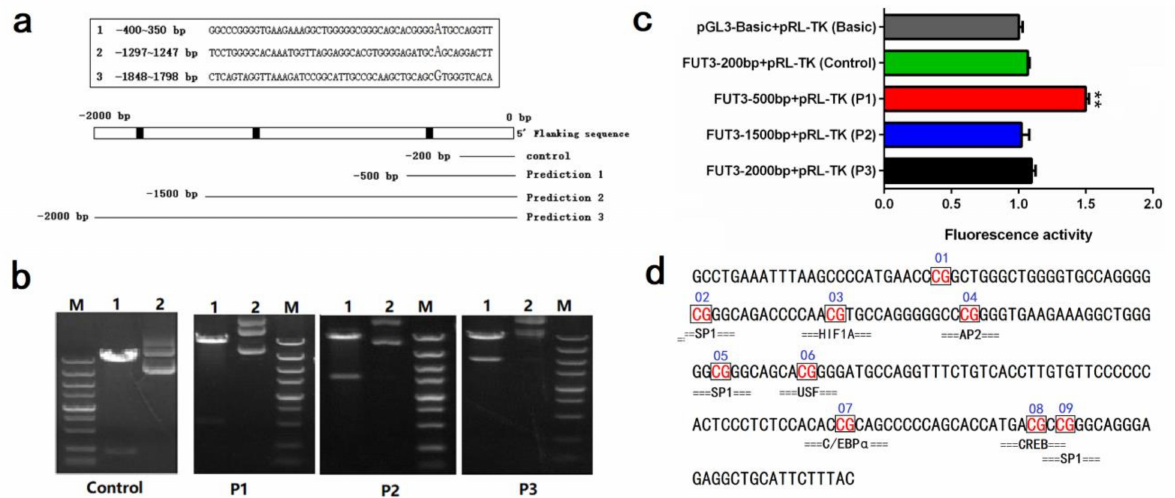
Figure 4. Identification of pig FUT3 gene core promoter region. ( a ) prediction of FUT3 core promoter region and truncation of detection fragment. ( b ) Agarose gel electrophoresis of PCR products that were digested by restriction enzymes. Lane 1: Plasmid digested by Kpn I and Hind III, Lane 2: Plasmid DNA, Lane M: DL5000 Marker. ( c ) Luciferase assay of different vectors. Basic: negative control. Results are indicated as mean ± SEM, n = 3 biological replicates, ** p < 0.01. ( d ) Methylation amplification fragment was designed using the MethPrimer software. Box labeled means the methylated CpG sites, below box means the predicted transcription factors.